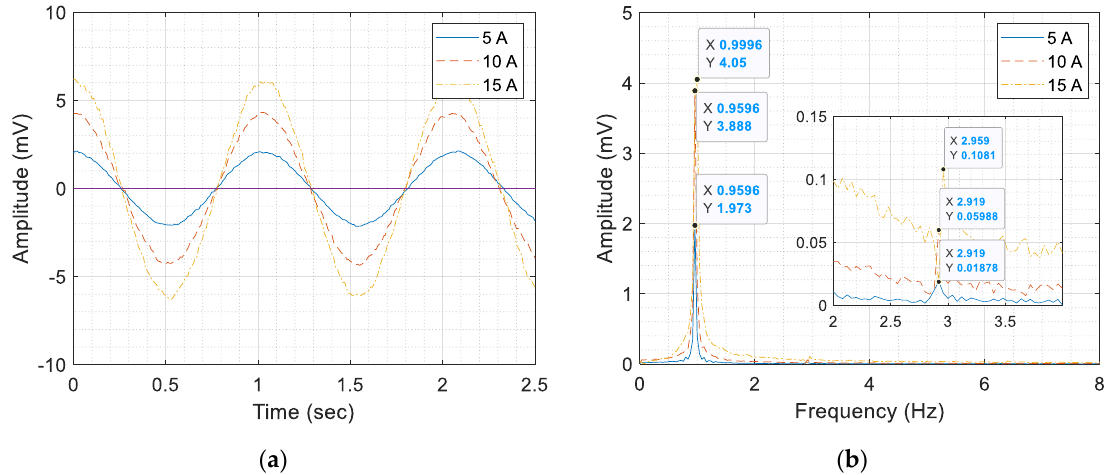
Figure 13. This figure shows the speed of the rotating coil 60 rpm (1 Hz): ( a ) the electromotive force of the magnetic field at 60 rpm; ( b ) the spectrum of the electromotive force of the magnetic field.